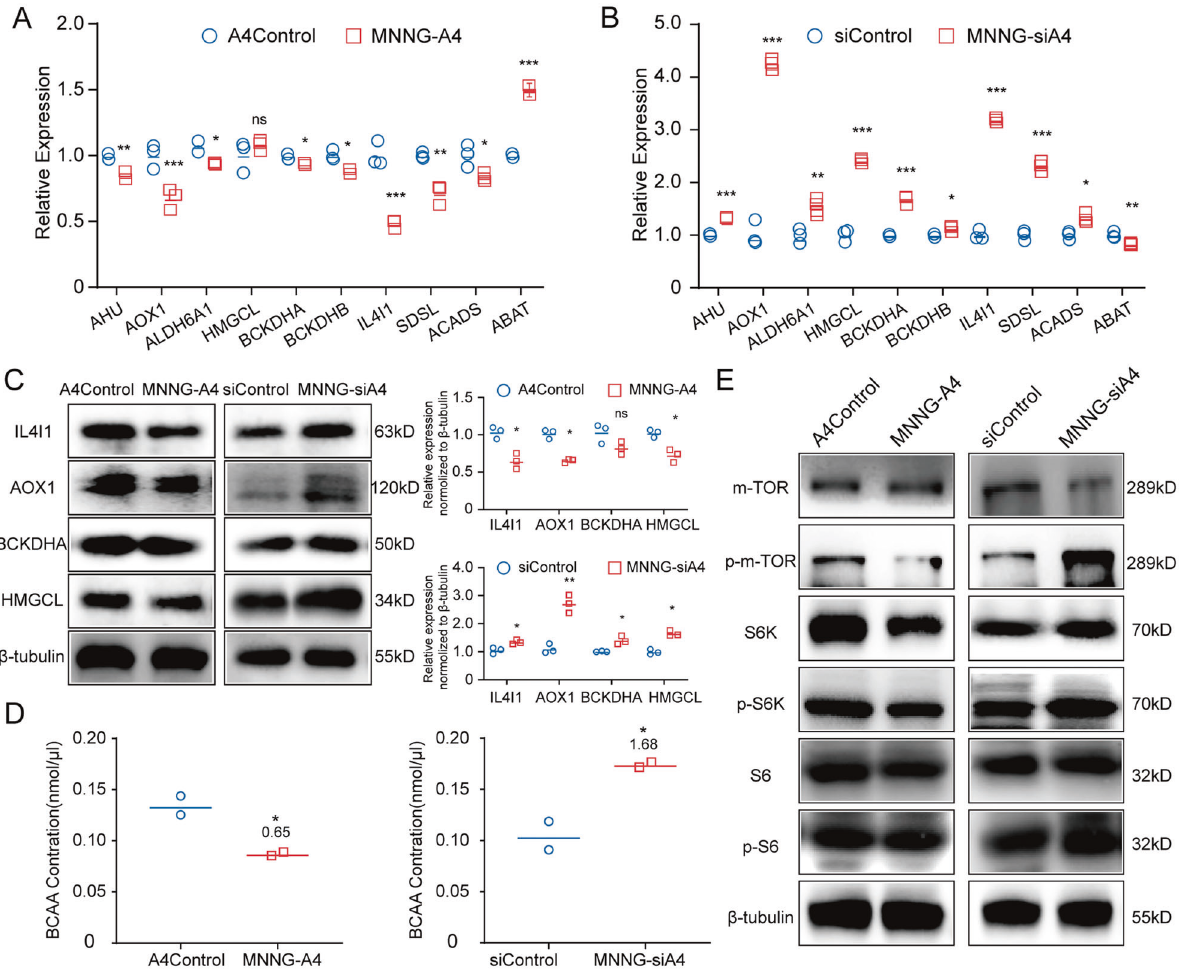
Fig. 4 Low expression of ANGPTL4 promotes the accumulation of BCAAs and activates mTOR signaling. A , B Among the DEGs, genes that are highly related to BCAA metabolism were veri fi ed by RT-qPCR in the ANGPTL4-regulated cells and their controls ( N = 3, ns p > 0.05, * p < 0.05, ** p < 0.01, *** p < 0.001 vs. the control group). C Proteins that are highly related to the BCAA metabolism were veri fi ed by western blot in the ANGPTL4-regulated cells and their controls. Quantitation of relative expression ( N = 3, ns p > 0.05, * p < 0.05, ** p < 0.01 vs. the control group). D The relative levels of BCAAs in MNNG-A4 cells, MNNG-siA4 cells, and their control cells ( N = 2, * p < 0.05, vs. the control group). E Western blot detection of proteins in the mTOR signaling pathway showed that this pathway was activated in the MNNG-siA4 cells but inhibited in the MNNG-A4